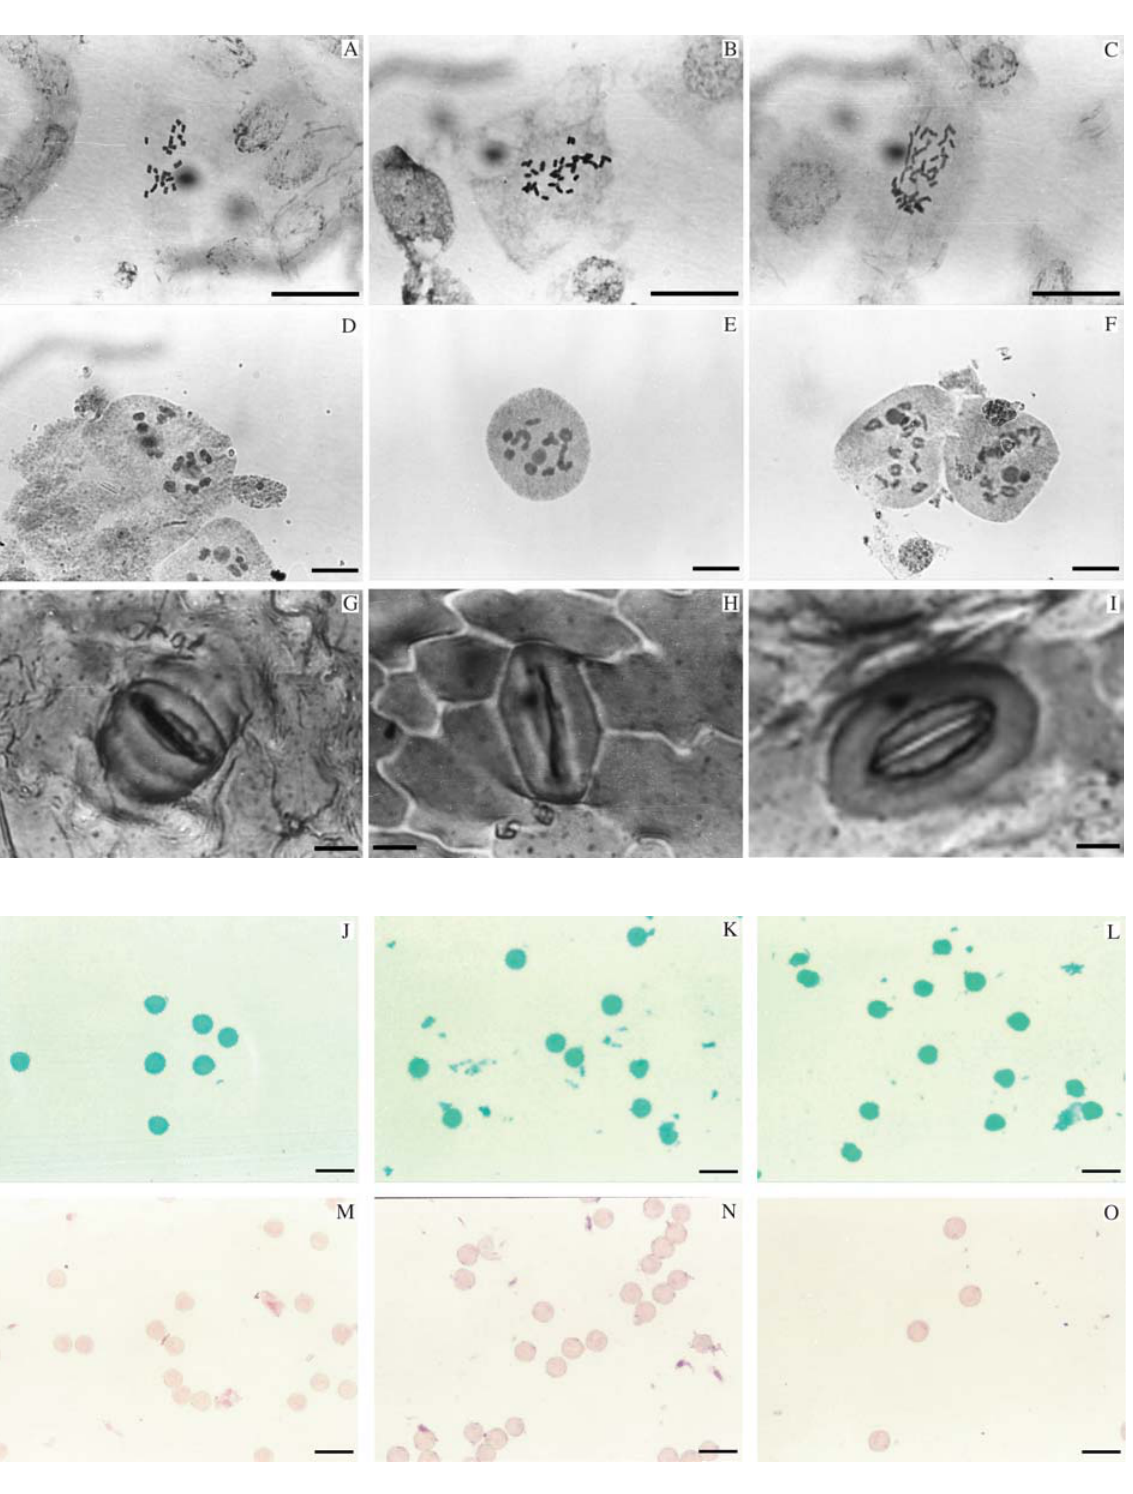
Figure 2 - Mitosis (A-C), meiosis (D-F), stoma (G-I) and pollen stained according to Alexander (J-L) or with acetic carmine (M-O) for strains of Stevia rebaudiana (Bertoni) Bertoni. A, D, G, J, M = Maringá F1 (2n = 22, n = 11 II ), B, E, H, K, N = T7V1 (2n = 33, n = 11 III ) and C, F, I, L, O = T6V3 (2n = 44, n = 11 IV ). N = nucleolus. Bars = 10 µm in A-F and 20 µm in